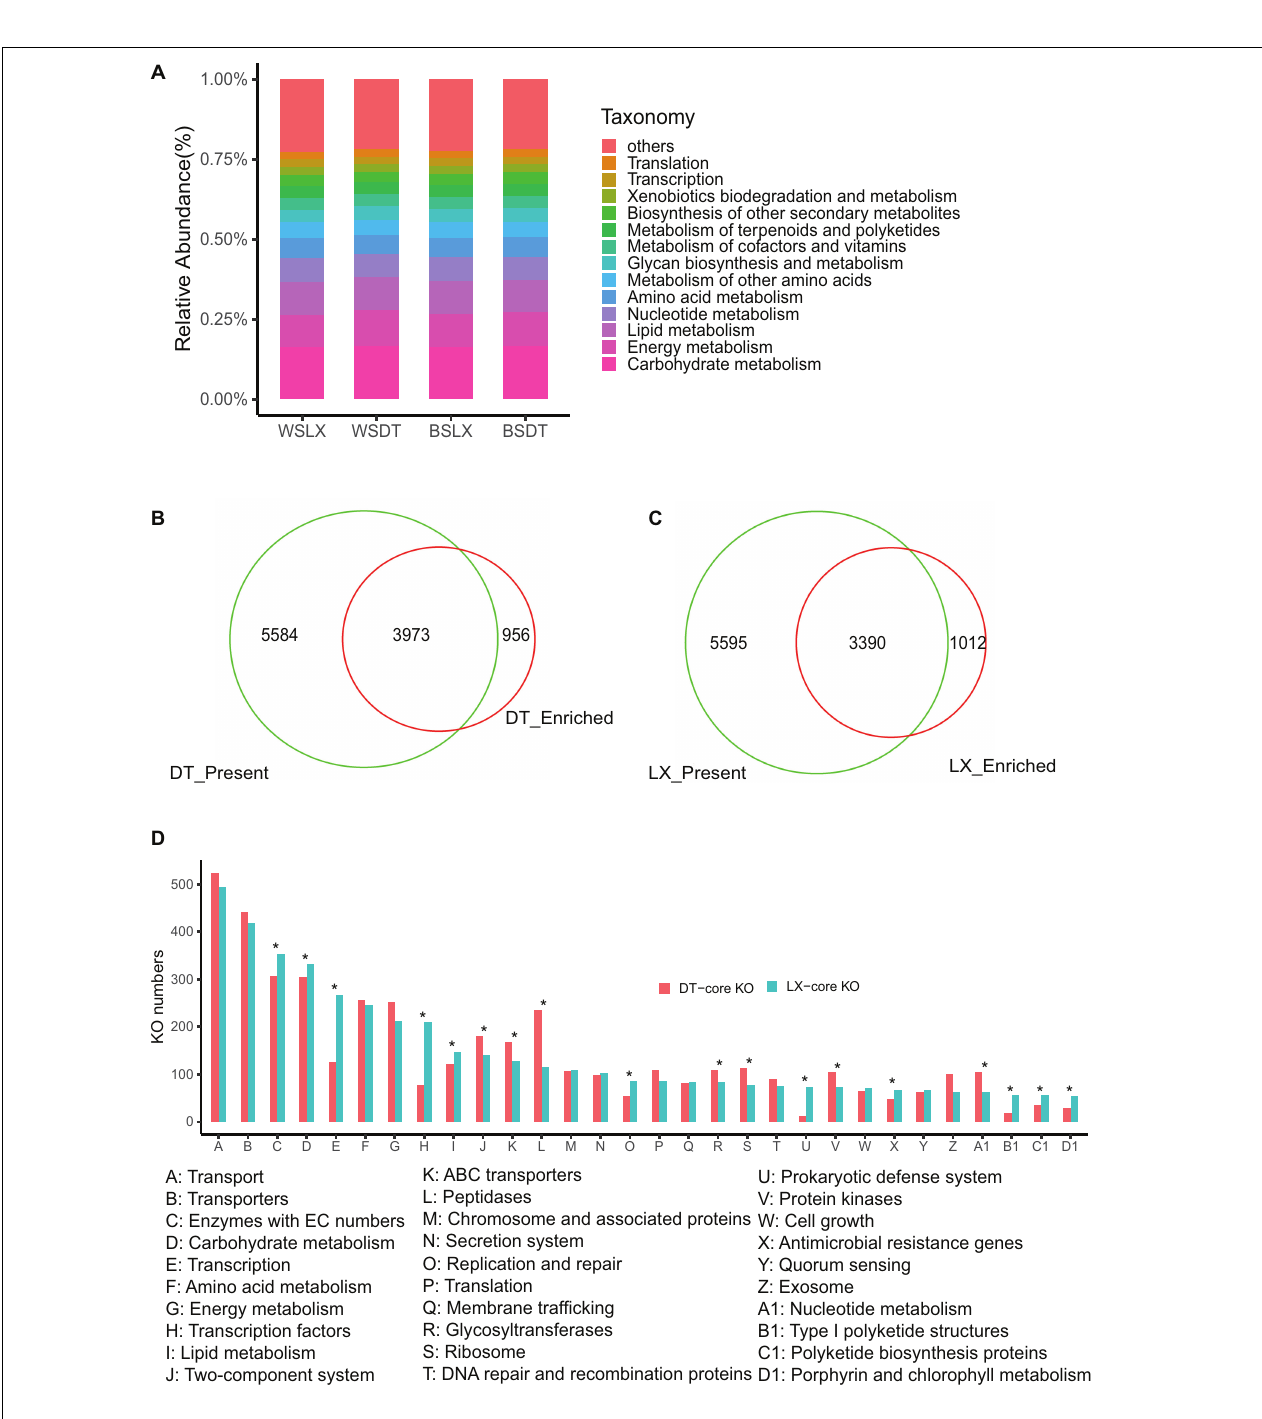
FIGURE 9 | Characterization of the core function of the P. notoginsen rhizosphere microbiome in different planting patterns. (A) Functional KEGG level 2 pathway comparison of P. notoginsen rhizosphere microbiomes. (B) Venn plot depicting the number of core rhizosphere KOs based on the presence rate ( > 75%) in all understory planting samples, the KOs have a higher relative abundance in understory planting than in cropland planting. (C) Venn plot depicting the number of core rhizosphere KOs based on the presence rate ( > 5%) in all cropland plantin samples, the KOs have a higher relative abundance in cropland planting than in understory planting. (D) The distributions of the rhizosphere core KOs in the KEGG level 3 pathways. Asterisk indicates a significant difference with P < 0.05 (MW test). WSDT, rhizosphere soil of cropland planting in Wenshan City, WSLX, rhizosphere soil of understory planting in Wenshan City; BSDT, rhizosphere soil of cropland planting in Baise City; BSLX, rhizosphere soil of understory planting in Baise City.